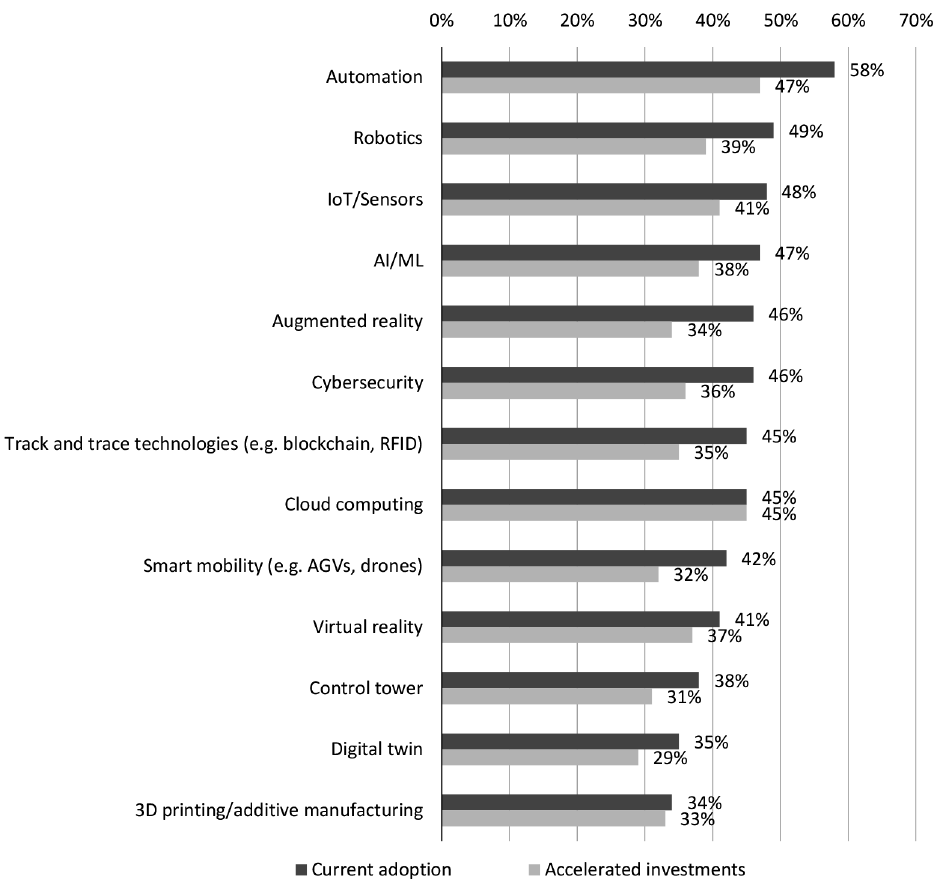
Figure 5. Adoption plans for managing SC during the Covid-19 pandemic in the area of